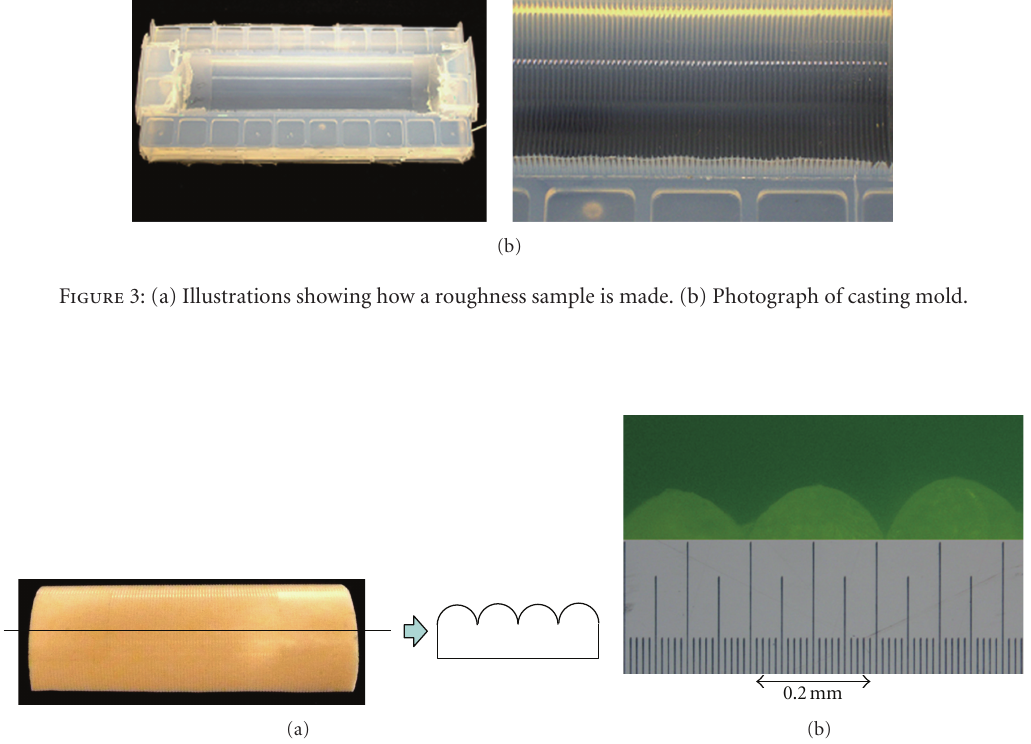
Figure 4: (a) Photograph of roughness sample. (b) Photograph of cross-sectional surface of the roughness sample (0.20mm-d). This sample was cut with a band saw.